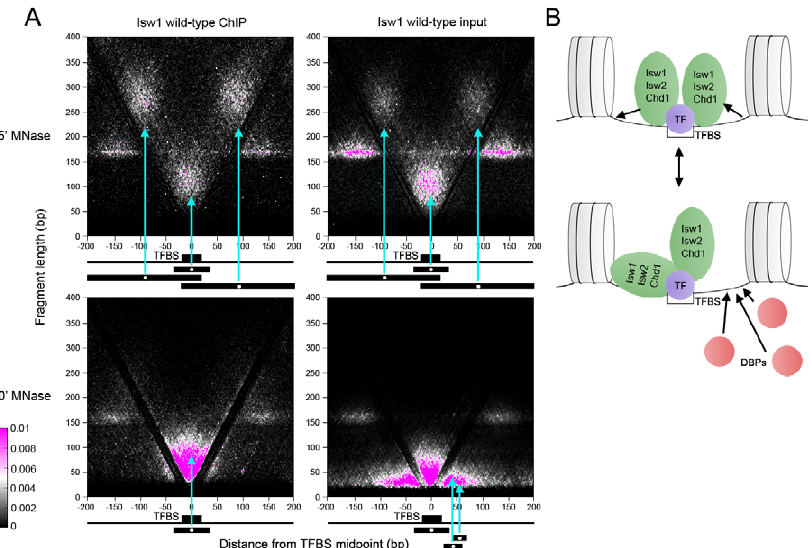
Figure 4. ISWI and CHD remodelers associate with TFBSs. (A) V-plots of wild-type Isw1 ChIP and soluble input chromatin at binding sites for the Abf1 TF after 2.5 9 and 10 9 MNase digestion. Flanking nucleosomes are visualized as well-defined dot clusters on either side of the TFBS. Example fragments contributing to the generation of various V-plot features are shown schematically below each plot. Cyan arrows point to the position of each fragment midpoint within the V-plot. Similar results were seen for wild-type Isw2 and Chd1 at Abf1 sites and for Isw1, Isw2, and Chd1 at Cbf1, Mbp1, and Reb1 binding sites (Figures S3 and S4). (B) Interpretive schematic of V-plot results. DBPs; DNA-binding proteins.